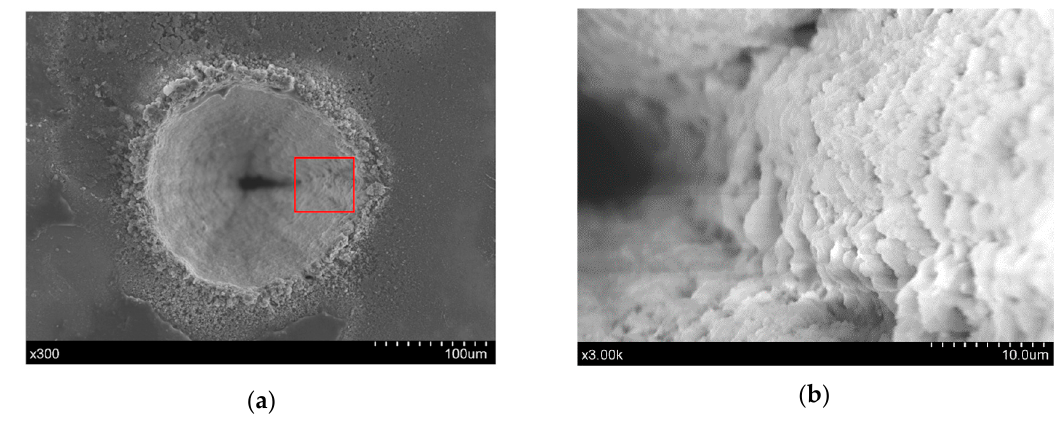
Figure 9. The laser dry trepanning results corresponding to test L4 in Table 3, where ( a ) is the whole view, while ( b ) depicts details of the irregular micro-humps distributed on the sidewall. The processing parameters include: P = 11.5 W, f = 1 MHz, v = 1200 mm/s, n = 25, and m = 120.